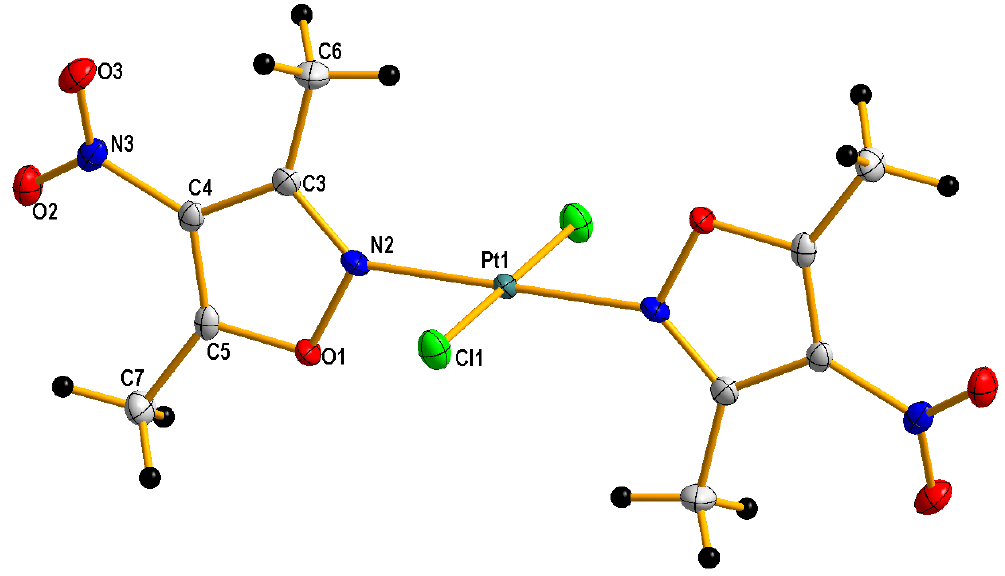
Figure 2. Crystal structure of trans-dichlorobis(3,5-dimethyl-4-nitro-isoxazole)platinum(II) with displacement ellipsoids drawn at the 50% probability level. Labelling scheme for asymmetric unit.